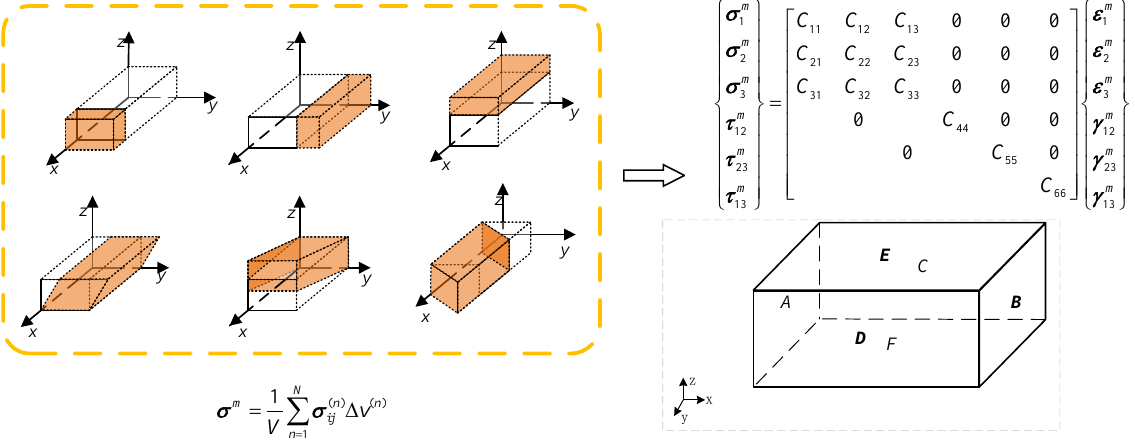
Figure 1. Schematic diagram of boundary conditions of the unit cell model.